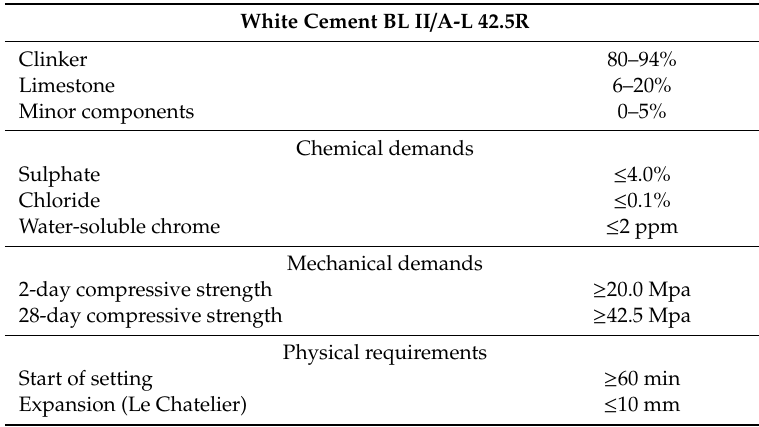
Table 2. Cement properties according to Lafarge.